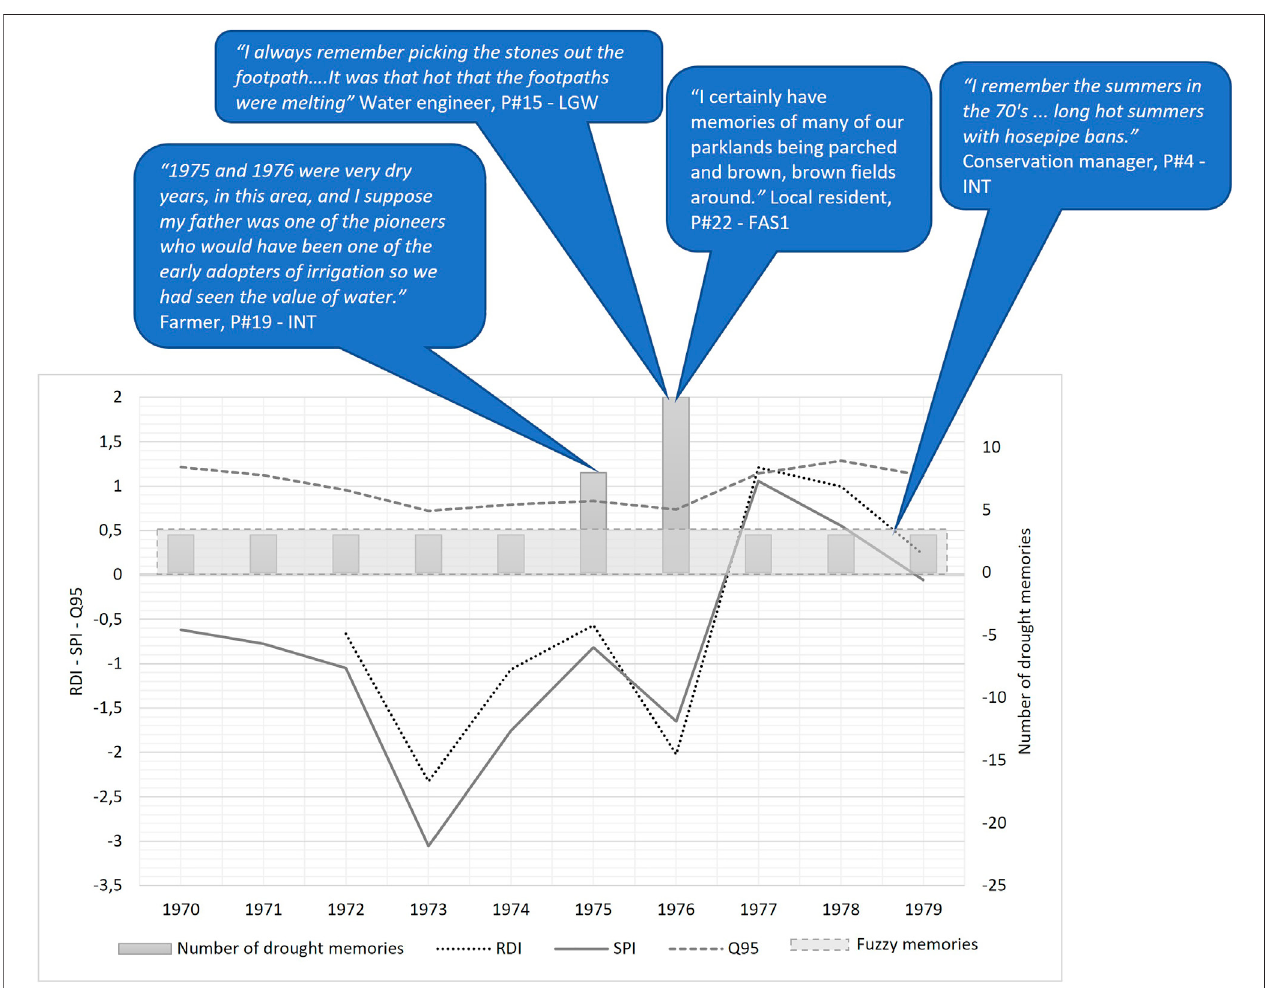
FIGURE 8 | Drought memories overlaid on SPI, RDI and Q 95 data for the decade 1970 to 1979.